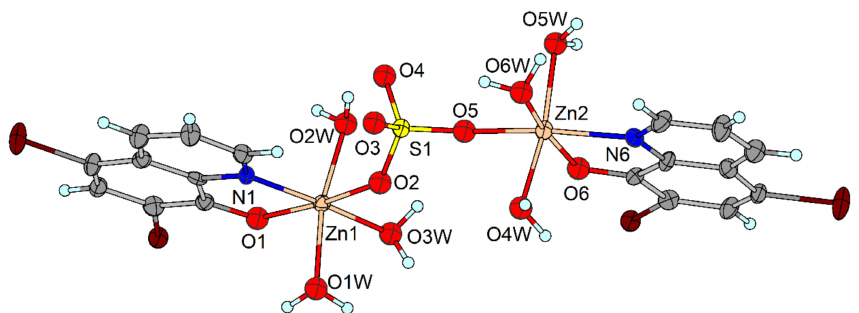
Figure 9. Molecular structure of 5 . Displacement ellipsoids are drawn at 50%